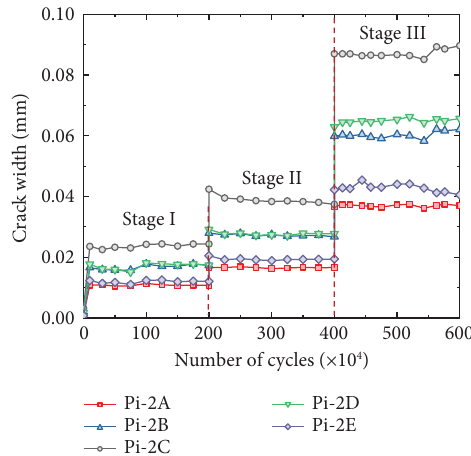
Figure 18: Variation laws of crack width during fatigue test.